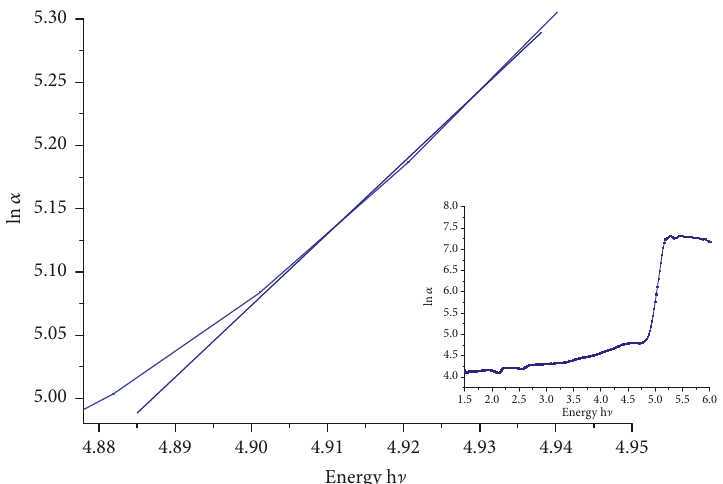
Figure 8: Linear portion plot of natural log of the absorption coefficient ( 𝛼 ) versus the incident photon energy and its inset.